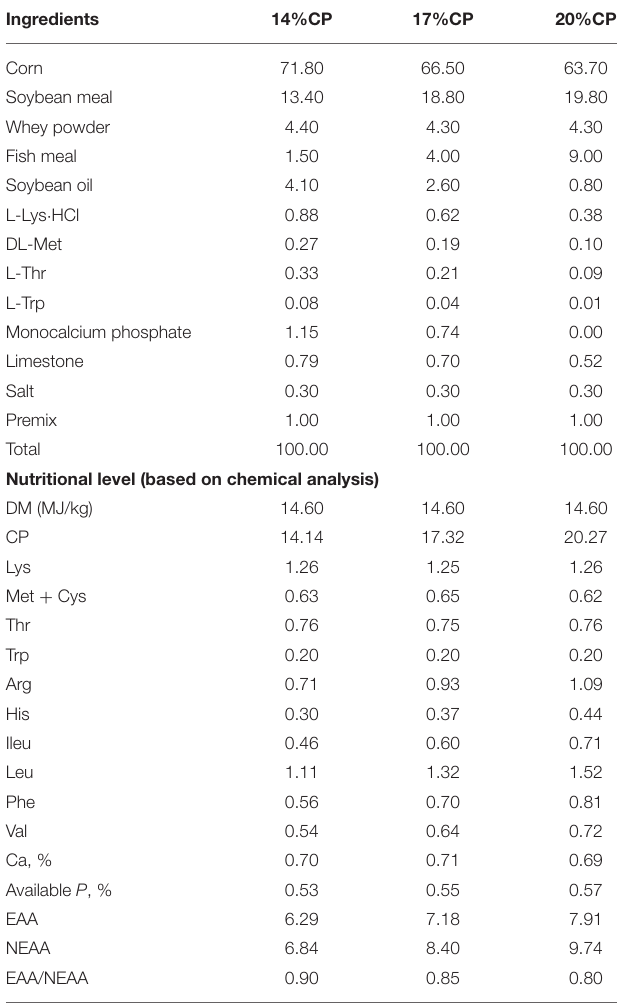
TABLE 1 | Ingredient composition of experimental diets in weaned piglets (g/kg, DM basis).